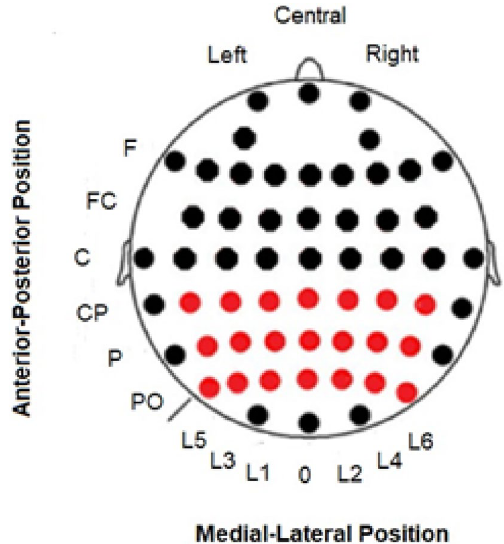
Figure 2. Electrode matrix selected to analyze spectral